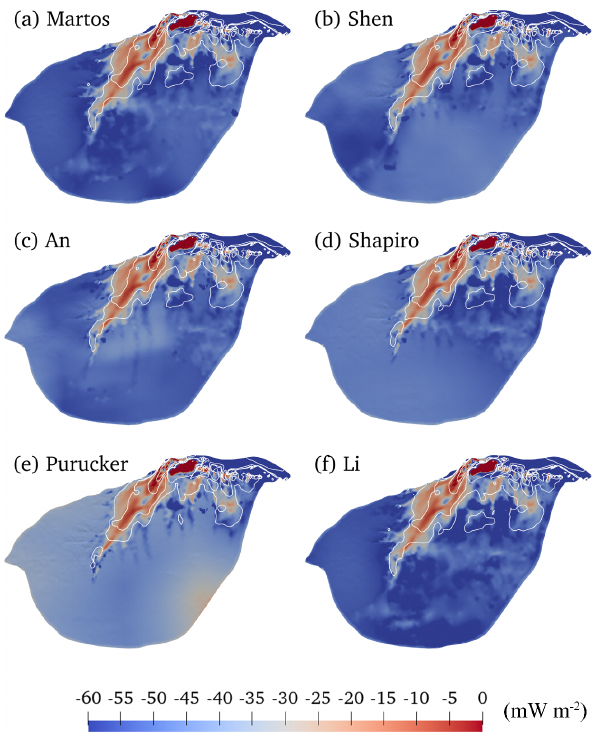
Figure 8. Modelled heat change in basal ice by upward englacial heat conduction (mWm − 2 ). The negative sign means that the up- ward englacial heat conduction causes heat loss from the basal ice, as defined by the colour bar with cooler colours representing more intense heat loss by conduction. Panels (a) to (f) correspond to the GHF in panels (a) to (f) in Fig. 2. The white solid curves represent modelled speed contours of 30, 50, 100, and 200myr − 1 , which is the same as in Fig.